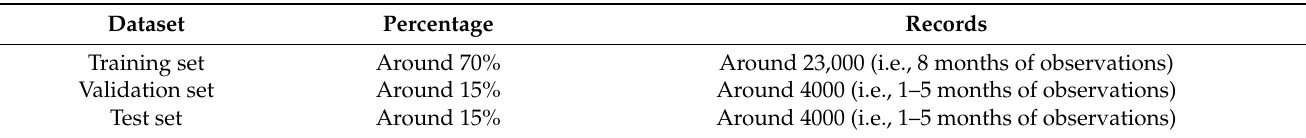
Table 3. Database split recap (one floor only) for models tailored on one